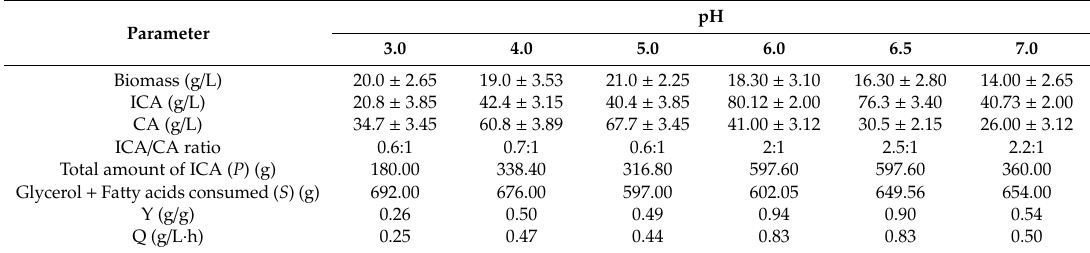
Table 4. E ff ect of pH on growth and ICA production by Y. lipolytica VKM Y-2373. Parameter